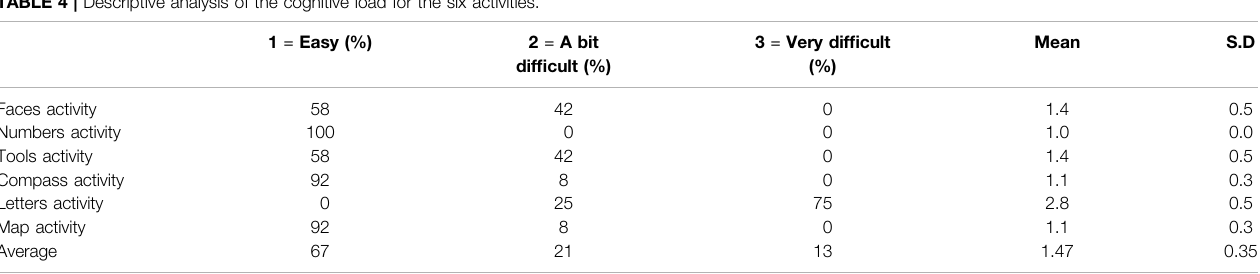
TABLE 4 | Descriptive analysis of the cognitive load for the six activities.